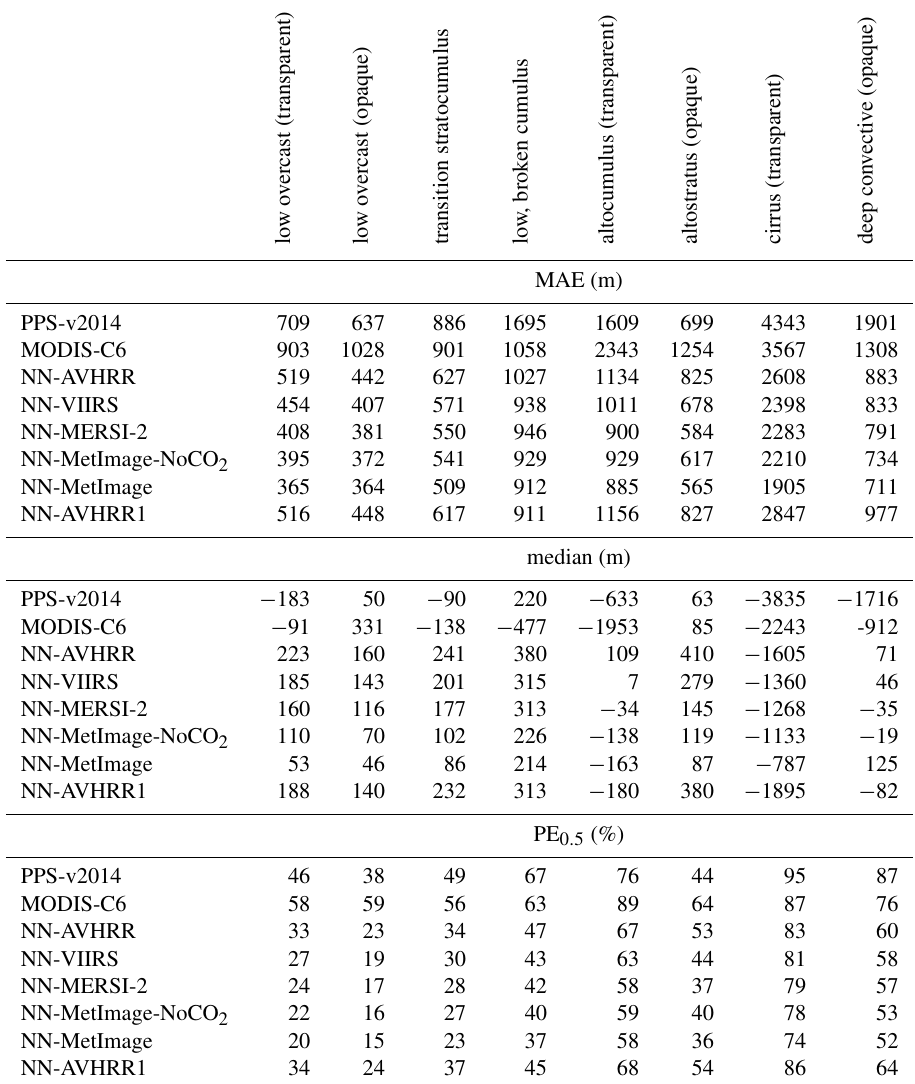
Table 10. Mean absolute error (MAE) and median in meters for different algorithms compared to CALIOP top layer altitude. The final validation dataset (see Table 1), containing 1803335 pixels (5% low overcast (transparent), 12% low overcast (opaque), 19% transition stratocumulus, 2% low, broken cumulus, 7% altocumulus (transparent), 8% altostratus (opaque), 30% cirrus (transparent) and 14% deep convective (opaque)), where all algorithms had a cloud top height is used. The cloud types are from CALIOP feature classification. PE 0 . 5 describes percentage of absolute errors above